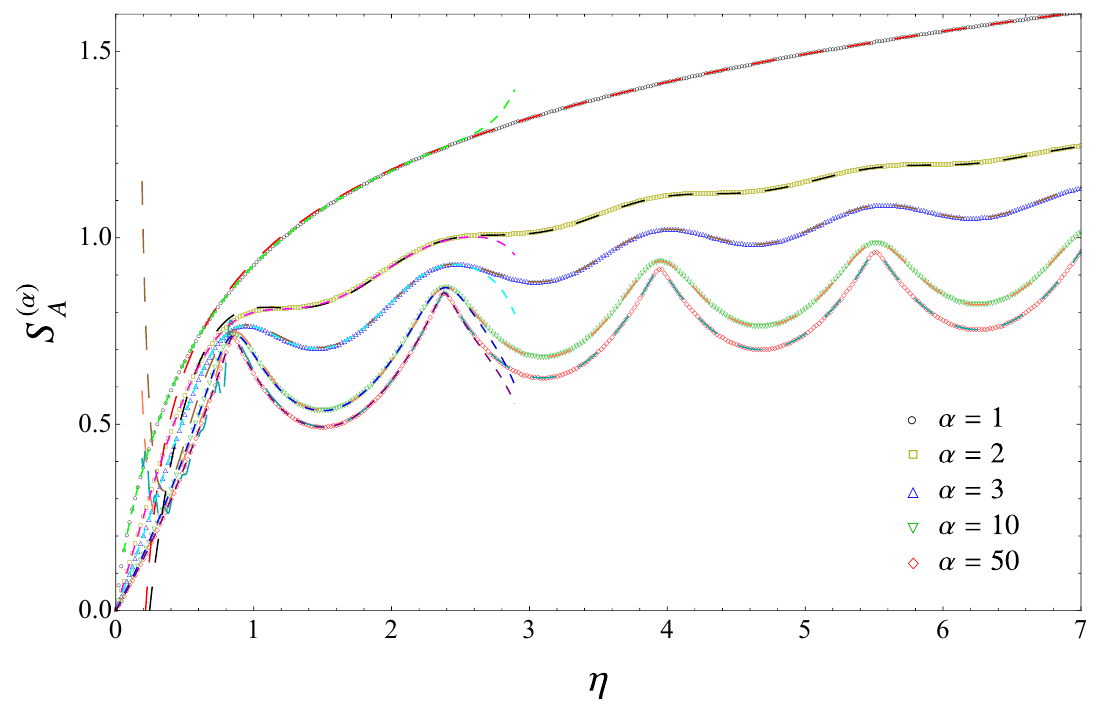
Figure 3. Entanglement entropies: the data points have been obtained from (4.1), while the dashed lines correspond to the small interval expansion (see (7.3)) and to the large interval expansion (see (8.15), (8.17) and